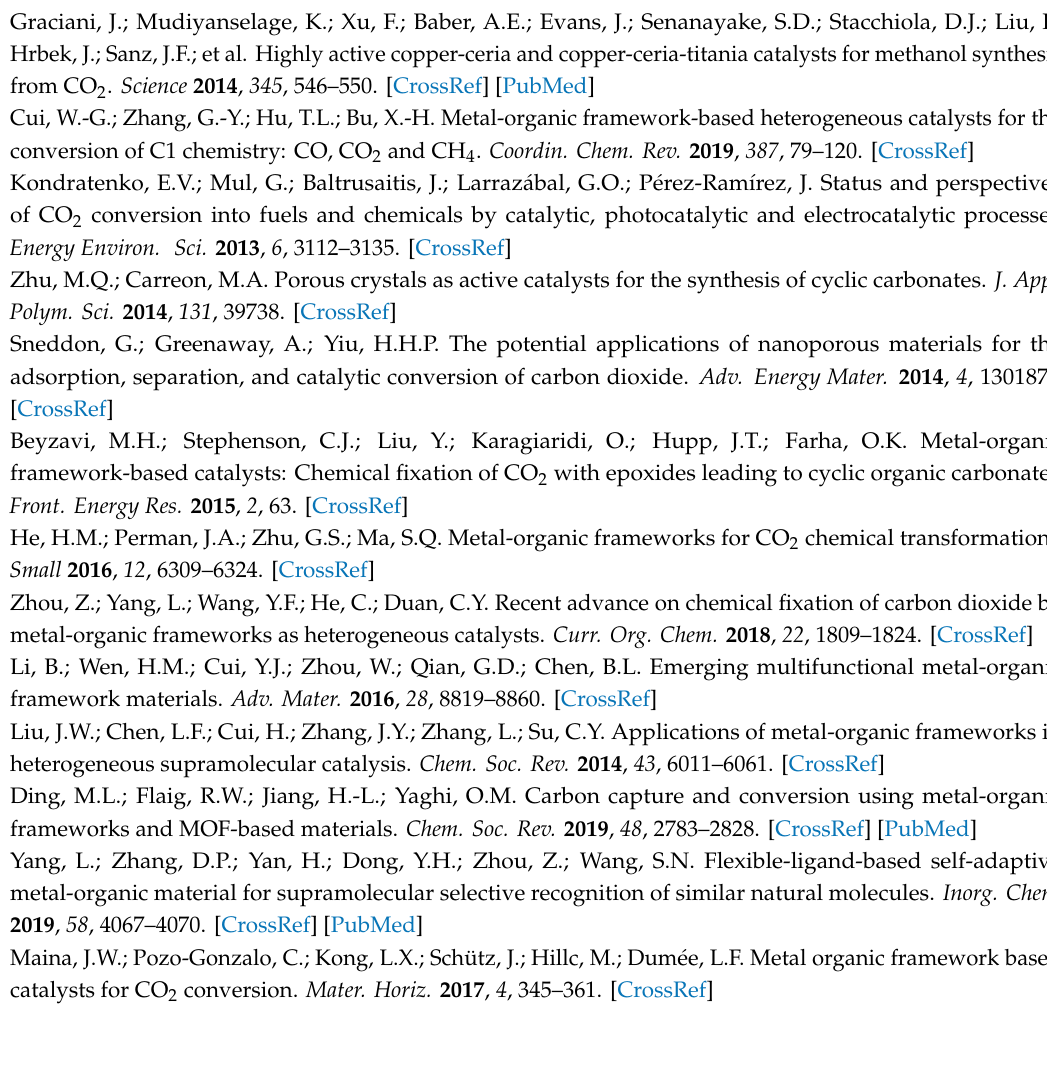
Figure S1: the 3D structural framework of 1 along a axis, Figure S2: the 3D structural framework of 1 along b axis, Figure S3: the truncated 3D structure and schematic representation of 1 network, Figure S4: structure comparison of 1 in this work and the reported MOF PCN-222, Figure S5: PXRD patterns of 1 (red), its calculated pattern based on the single-crystal simulation (black) and the activated sample after desolvation (blue), Figure S6: TG curve of 1 , Figure S7: Gas adsorption isotherms of activated 1 of N 2 at 77 K, Figure S8: The structure of RhB molecule used in the dye adsorption experiments, Figure S9: The recycling experiments of 1 at each round, Figure S10: IR spectra of 1 and the sample after reaction. Author Contributions: L.Y. and Z.Z. conceived and designed the experiments; L.Y. and Y.D. fabricated and tested the experiments; D.Z. and S.W. analyzed the experimental data; L.Y. and Z.Z. wrote, reviewed and edited